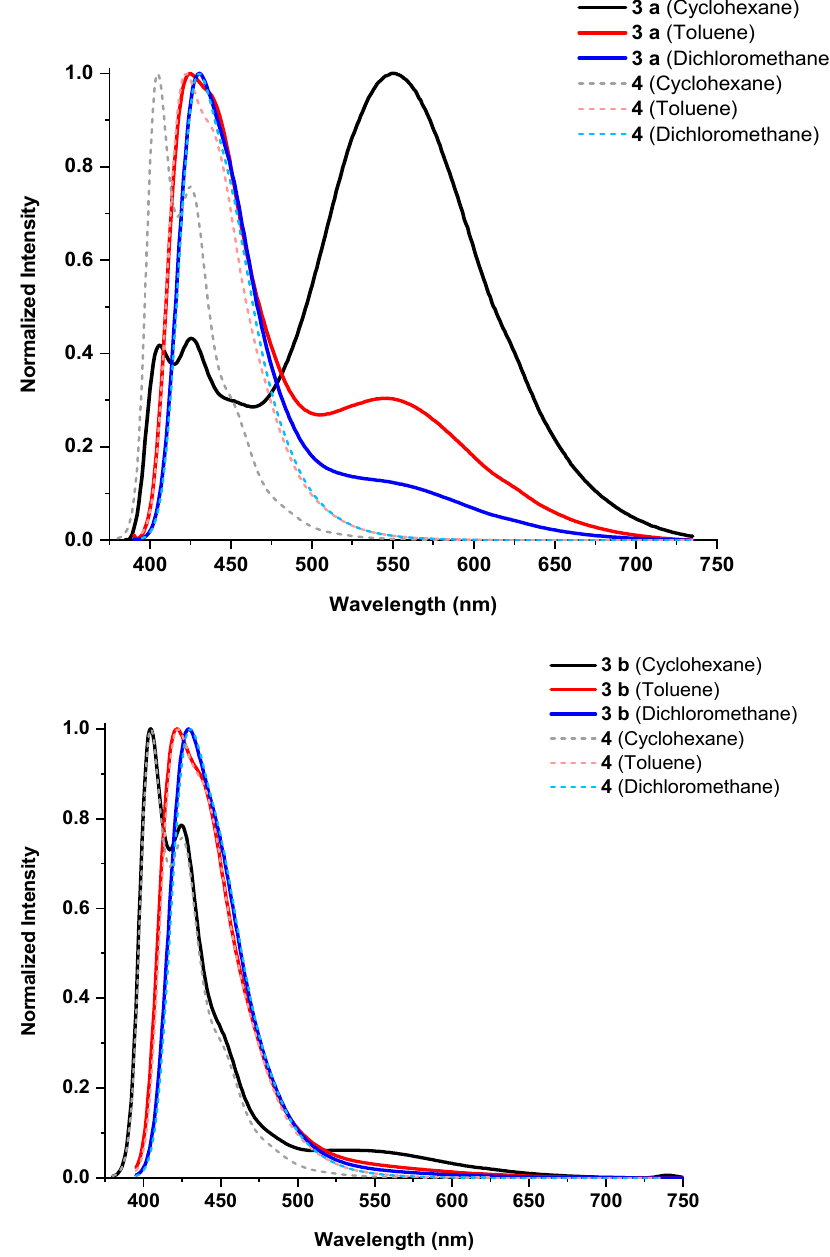
Figure 24. Normalized emission spectra of polymers 3 a,b in various solvents (RT, OD < 0.1). Excitation at 375 nm. Table 2. Optical properties of polymers 3 a,b and model compound 4 .